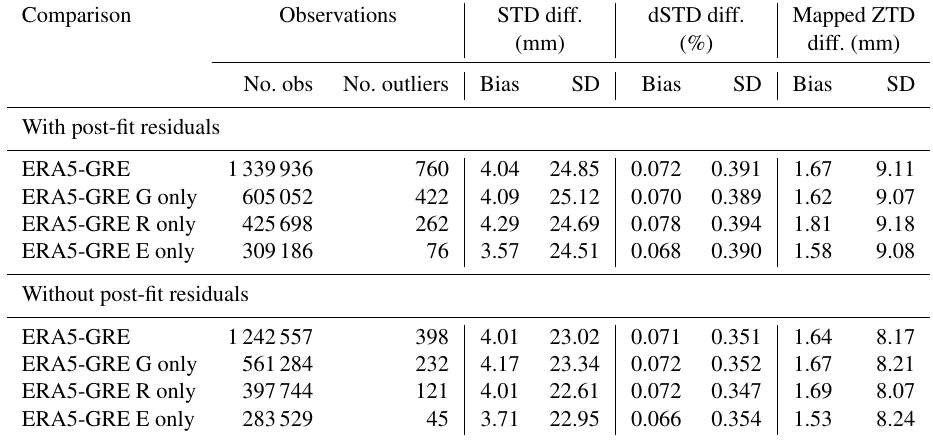
Table 8. The STD biases and standard deviations between ERA5 and the GRE solution with and without post-fit residuals. The statistics are calculated four times per day (at 00:00, 06:00, 12:00, and 18:00UTC) and averaged over October 2020. Comparison Observations STD